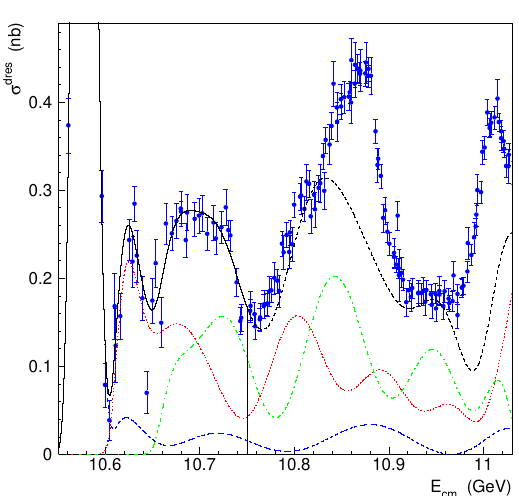
Figure 10 . Energy dependence of the total b ¯ b dressed cross section from ref. [19] (blue dots). Solid black curve is the result of the simultaneous fit to this distribution and the exclusive B ¯ B , B ¯ B ∗ , and B ∗ ¯ B ∗ cross section energy dependence (figure 8). Vertical line at 10 . 75 GeV indicates the upper boundary of the fit interval; dashed black curve is an extrapolation of the fit function. Also shown are the individual contributions of B ¯ B (blue dashed curve), B ¯ B ∗ (red dotted curve), and B ∗ ¯ B ∗ (green dash-dotted